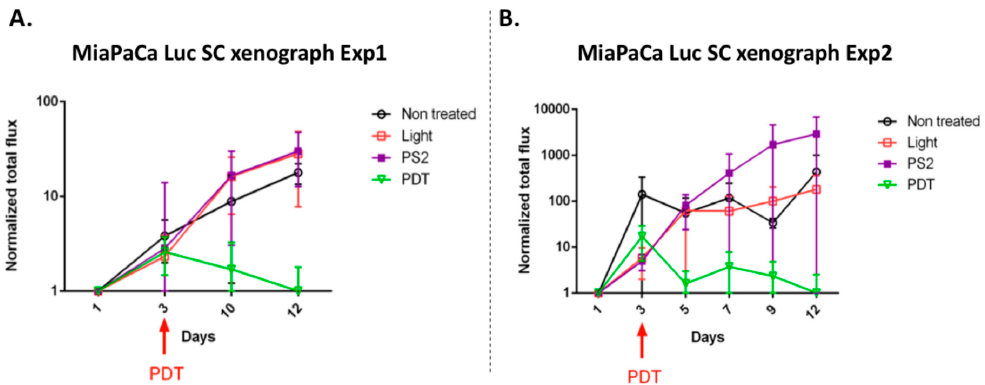
Figure 7. In vivo evaluation of PDT efficacy in a humanized Severe Combined ImmunoDeficiency (SCID) mice model of pancreatic cancer in one set of experiment ( A ) and for a second set of experiment ( B ). n = 3 per condition per experiment.